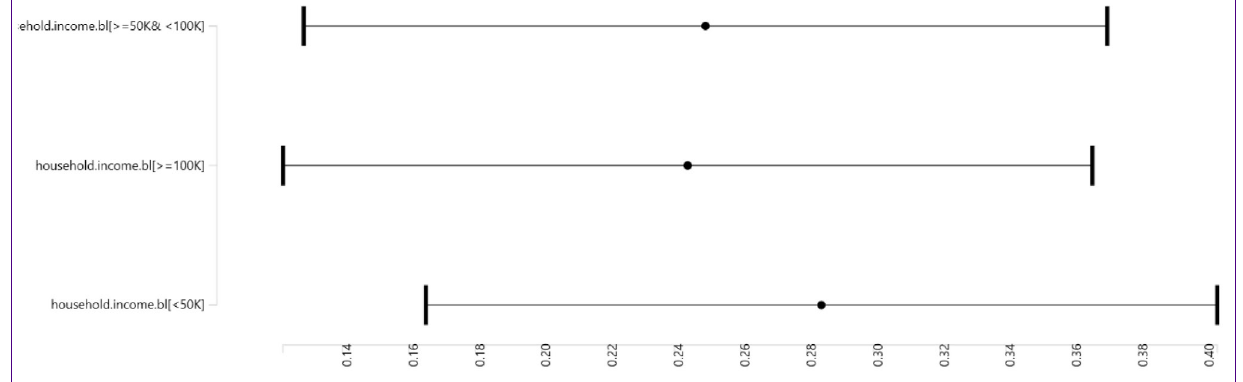
Figure 1. Association Between Household Income and Perceived Discrimination